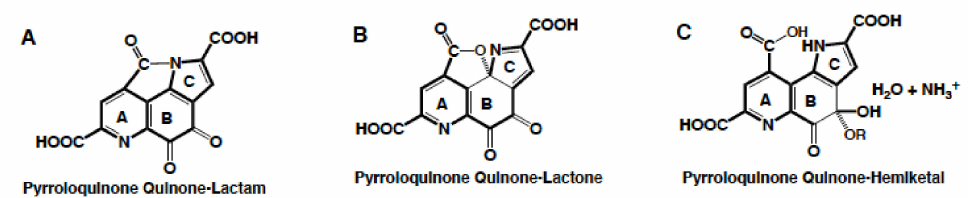
Figure 5. PQQ derivatives. PQQ can tautomerize under acidic conditions to form lactones ( B ), lactams ( A ) and hemiketals ( C ). In addition, PQQ readily engages in nucleophilic additions and